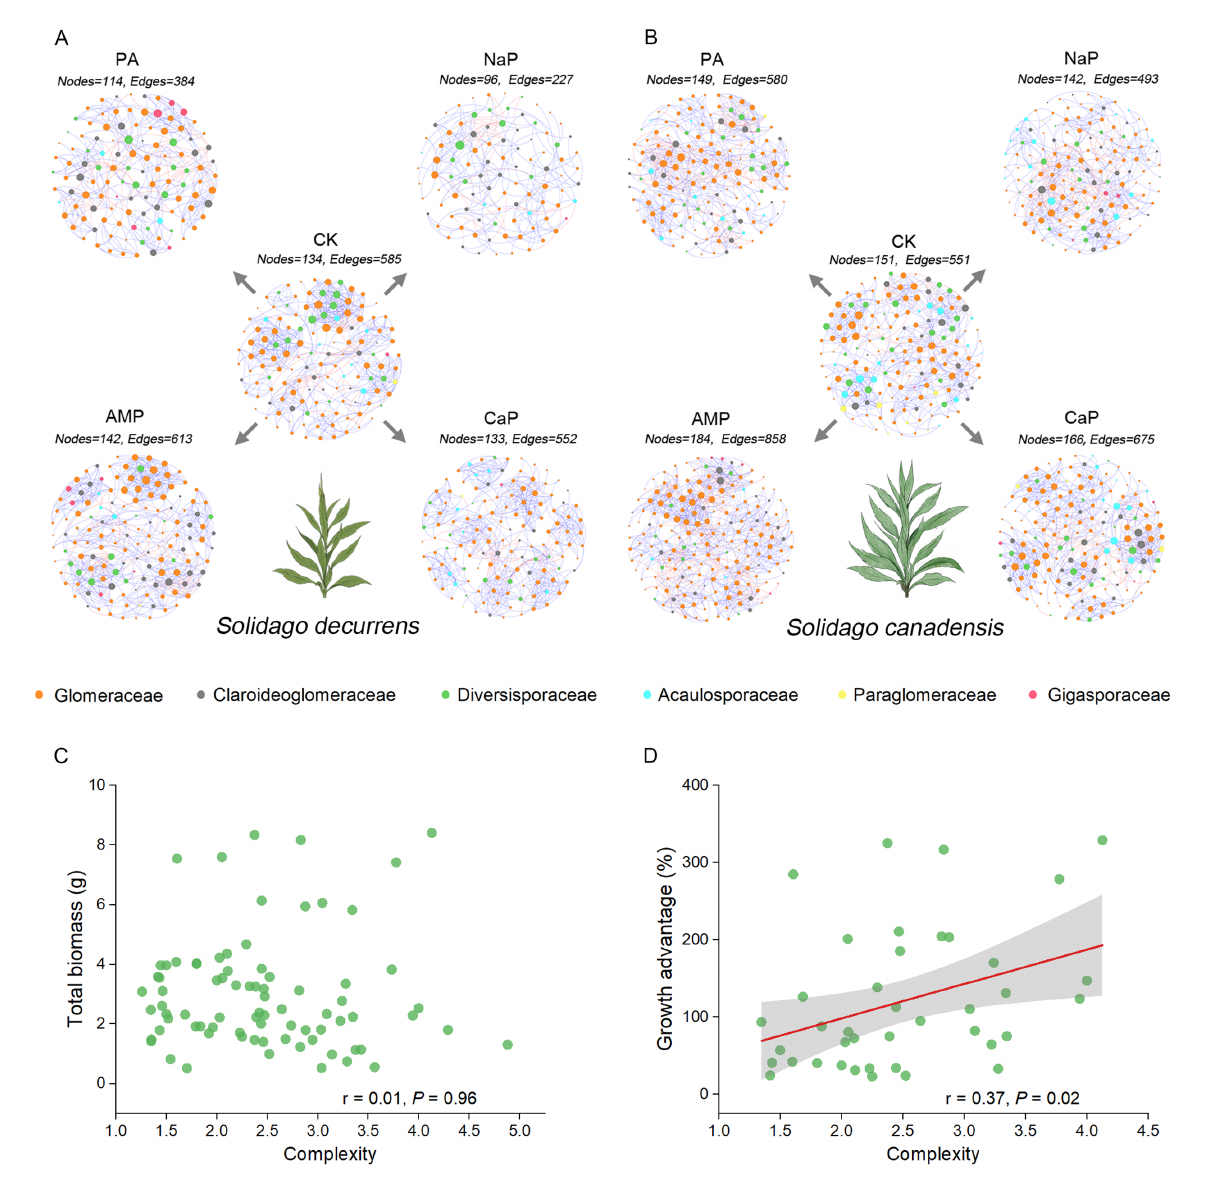
FIGURE 5 The AMF co-occurrence networks of (A) S. decurrens and (B) S. canadensis under five P treatments were visualized to show the significant associations ( r > 0.50, p < 0.05) between AMF ASVs. CK: no P addition; NaP: sodium dihydrogen phosphate; CaP: hydroxyapatite; AMP: adenosine monophosphate; PA: myo-inositol hexakisphosphate. Each node represents an ASV, different colors represent different families, the node size represents the degree of the node, and edges denote significant correlations between ASVs (blue: positive correlation; red: negative correlation). Pearson correlations